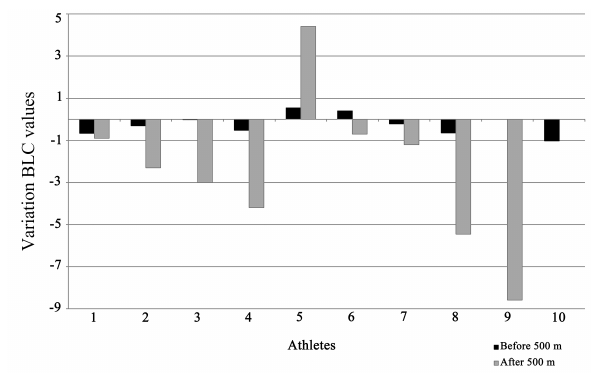
Fig. 5. Variation of BLC values before (black) and after (grey) the 500 m race simulation for each athlete (1 to 10) at which moment of study considering the two AR conditions. Variation = (BLC with vest) – (BLC without